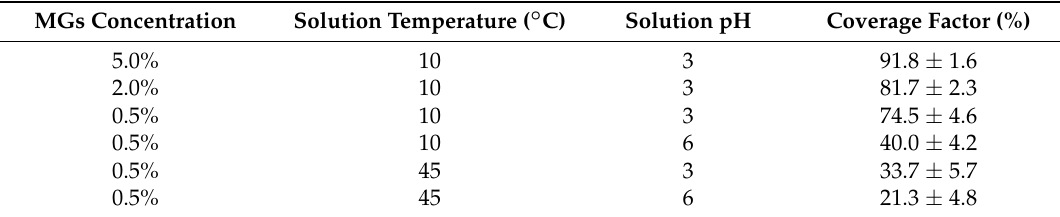
Table 1. Coverage factors obtained at different temperatures, pHs and MGs concentrations. The absolute uncertainty corresponds to the standard deviation evaluated over 5